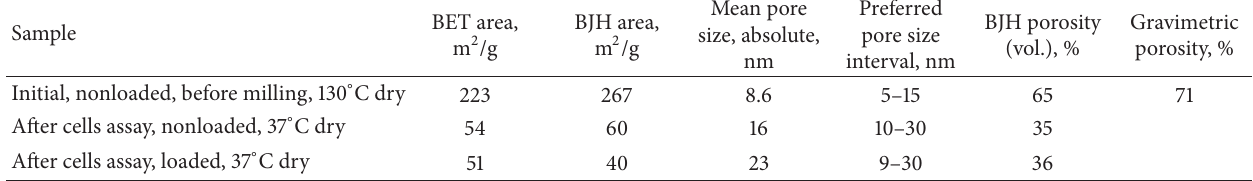
Table 1: Structural and surface parameters of the mesoporous samples (adsorption data).